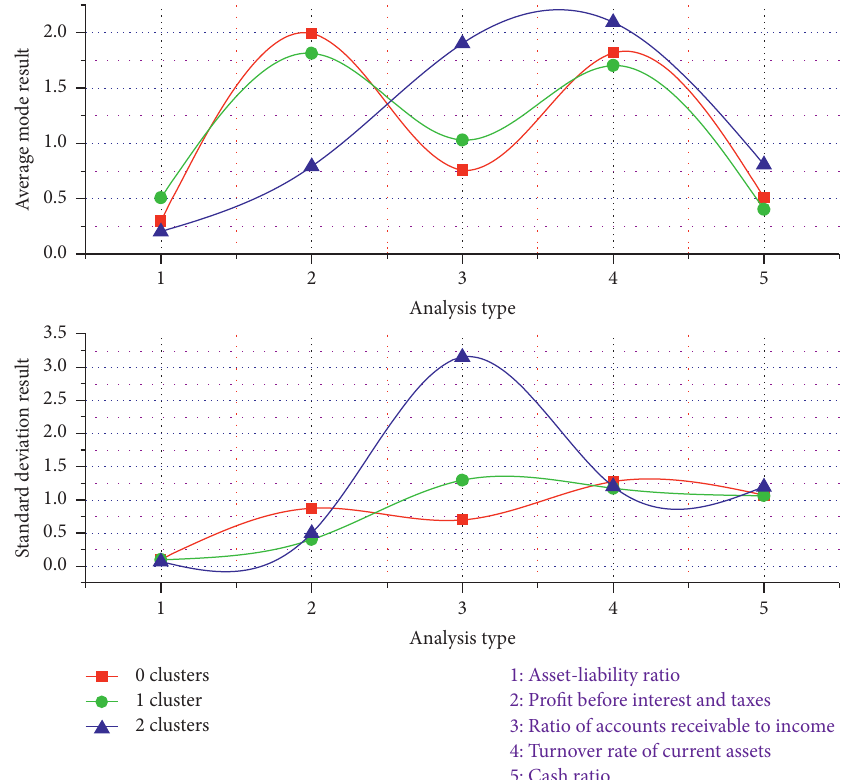
Figure 4: Statistical characteristics of